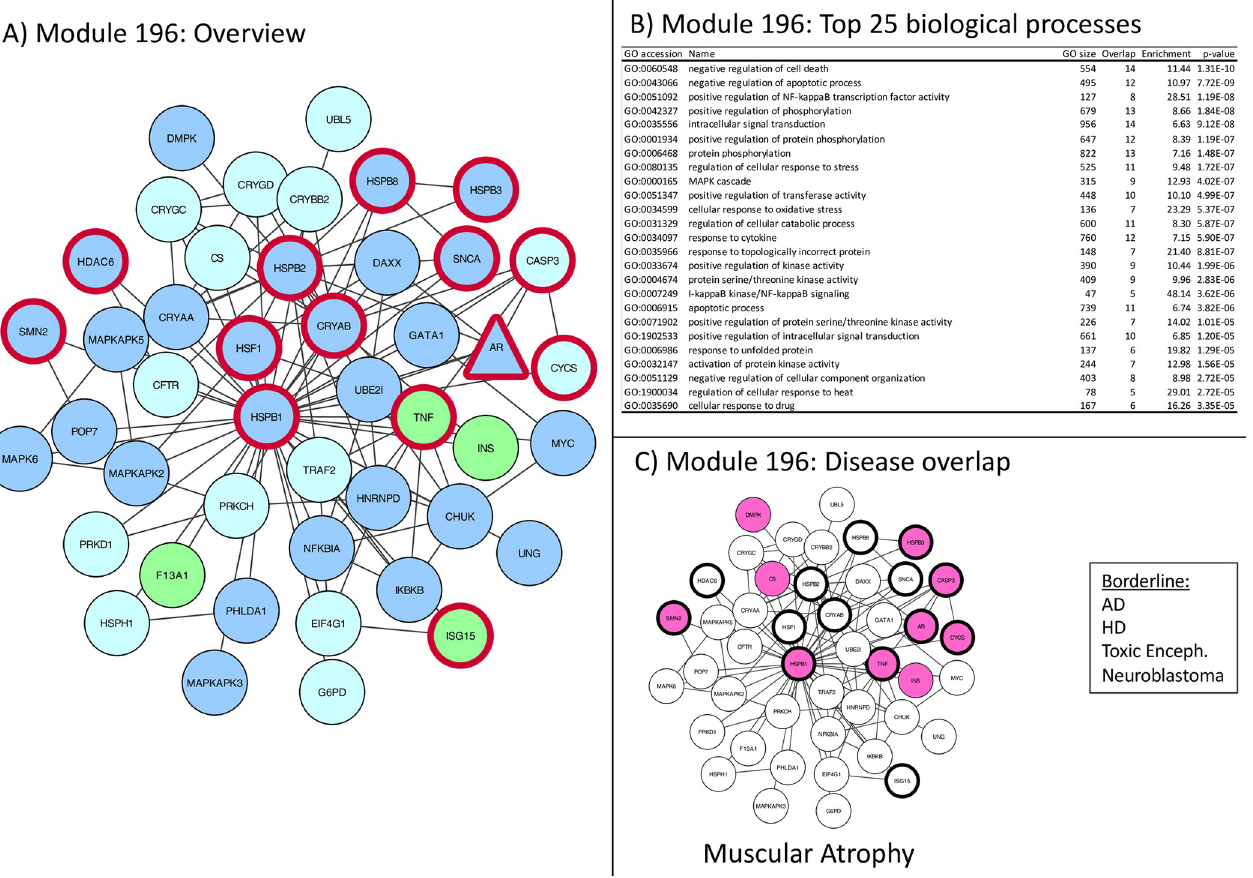
Fig 6. Module 196 –apoptosis and oxidative stress related. Panel A: thick red border: gene/protein annotated to be ALS-associated on any of the 7 lists. Large red label: gene/protein with GWAS evidence. Triangular shaped nodes: receptors (UniProt keyword). Node colors indicate subcellular location (UniProt keywords): Blue = Nuclear, Green = Secreted, Purple = conflicting nuclear/secreted, cyan = neither nuclear nor secreted (likely cytosolic). Panel B: Gene Ontology overrepresentation analysis. Panel C: Thick border: ALS-associated (as panel A), Colored node: Disease-associated gene/protein.